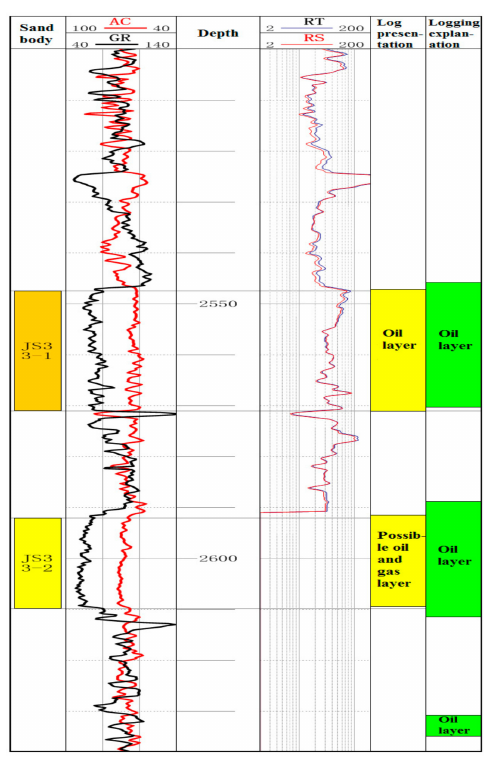
Figure 8. Histogram from the comprehensive analysis of well data (The red curve on the left is acoustic log (AC), and the unit of AC is us/ft. The black curve is natural gamma ray log (GR), and the unit of GR is API. The blue curve is true formation resistivity log (RT), and the unit of RT is OMM. The red curve on the right is shallow investigate double lateral resistivity log (RS), and the unit of RS is OMM.).